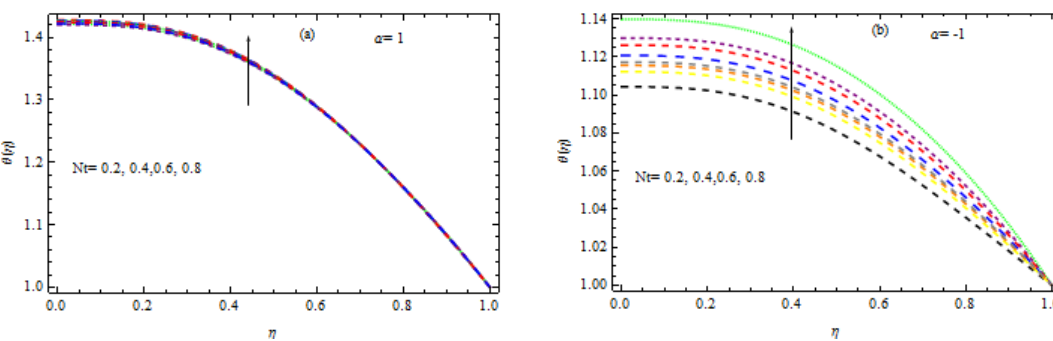
Figure 10. ( a , b ) Influence of Nt on temperature.